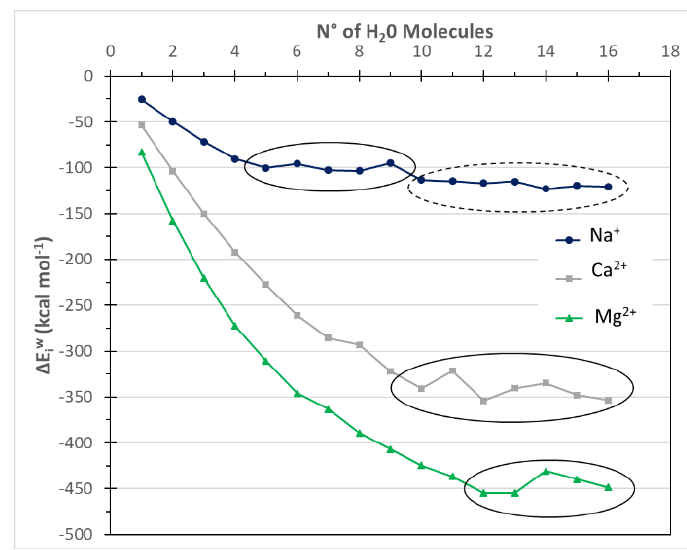
Figure 2. ΔE iw for the target cation as function of the hydration level, i.e., N° is the number of water Figure 2. ∆ E i w for the target cation as function of the hydration level, i.e., N ◦ is the number of water molecules. Solid circles indicate the ΔE iw plateaus referred to the first hydration shell, while the molecules. Solid circles indicate the ∆ E iw plateaus referred to the first hydration shell, while the dashed dashed circle indicates the formation of the second hydration shell. circle indicates the formation of the second hydration